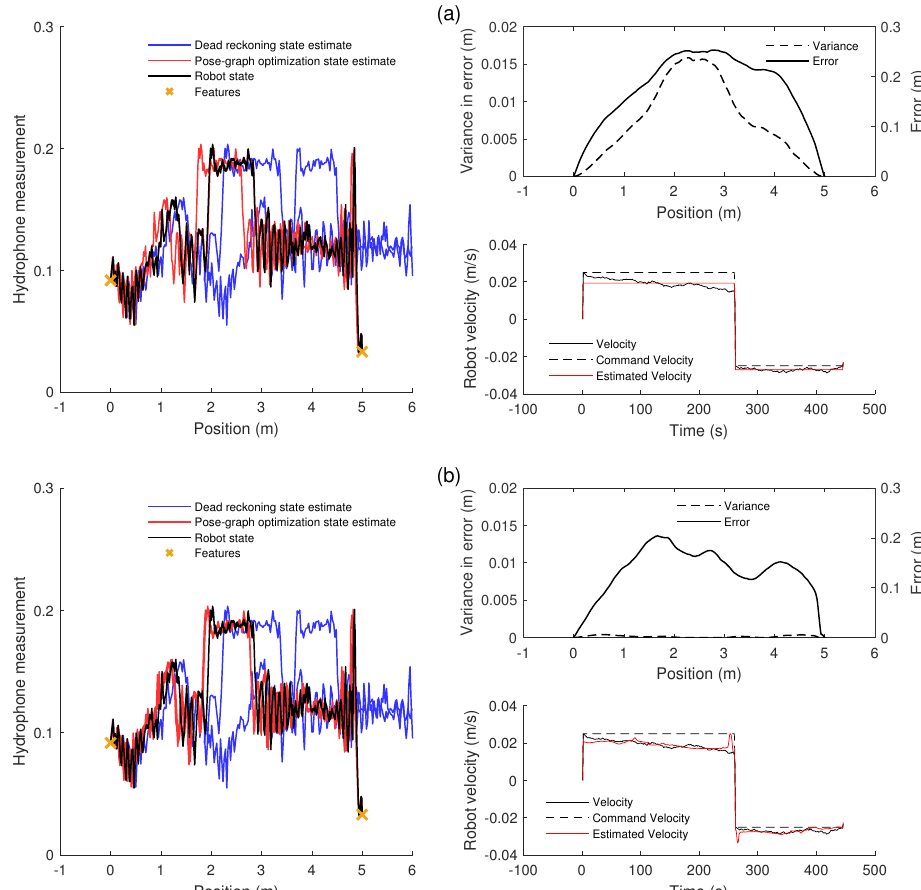
Figure 6. Results from using the developed methods to improve the trajectory estimate in a single 1D pipe: ( a ) an example of the results of the one-dimensional pipe trajectory optimization, using typical pose-graph optimization, illustrated by the resulting spatial signal estimation. The non-optimized estimate (blue) shows large inconsistency and error. The optimized estimate (red) shows some consistency, as the two signals are within the boundaries of the pipe, and accuracy, as the signals coincide well with the true spatial signal (black). The variance in the error, a measure of the inconsistency of the estimates, is shown along with the magnitude of the error for each point along the pipe. The velocity estimate is also shown, showing the drifting velocity in black and the simple estimate of a fixed velocity in red. ( b ) An example of the results of the one-dimensional pipe trajectory optimization illustrated by the resulting spatial signal estimation using the quadratic fit prediction and phase-correlation methods: The non-optimized estimate (blue) shows large inconsistency and error. The optimized estimate (red) shows consistency, as the two signals are aligned, and accuracy, as the signals coincide well with the true spatial signal (black). The variance in error, a measure of the inconsistency of the estimates, is shown along with the magnitude of the error for each point along the pipe. The velocity estimate is also shown, showing the estimated velocity in red closely matching the drifting velocity in